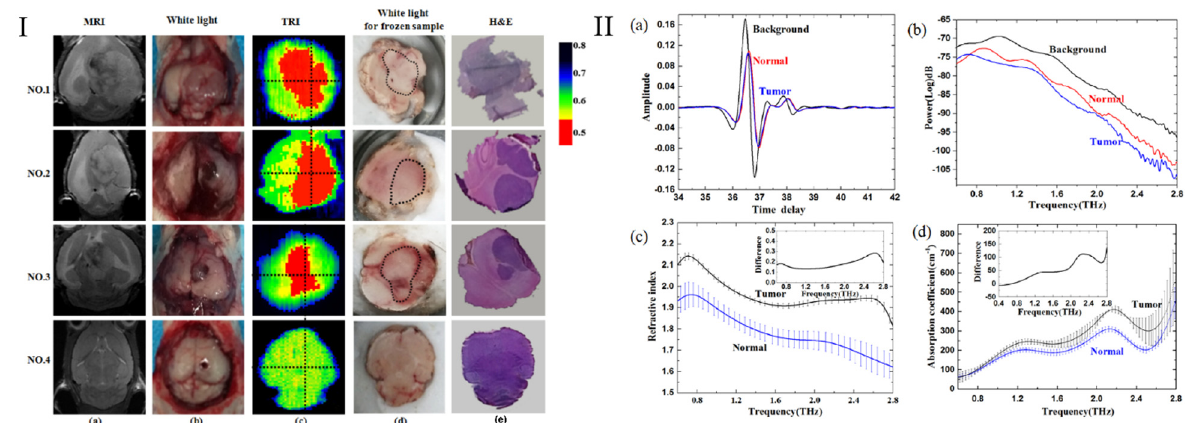
Figure 8. I: ( a ) Magnetic resonance imaging (MRI), ( b ) White light, ( c ) THz CW reflection image (TRI), ( d ) visualization of fresh excised, and ( e ) images of whole-brain tissue H&E-stained slides with (Nos. 1–3) and without (No. 4) tumors. II: ( a ) The THz-TDS signal, ( b ) the power, ( c ) the refractive index, and ( d ) the absorption coefficient of the freshly excised brain tissue samples. Adapted from [157].